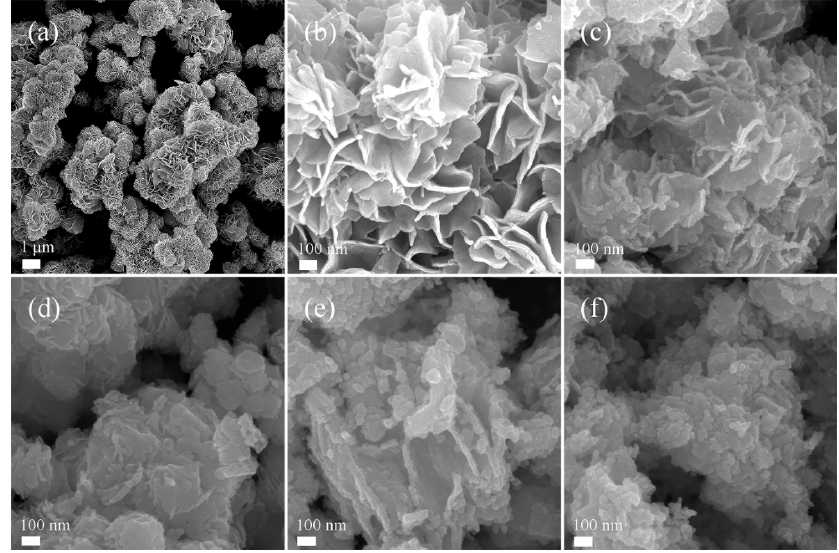
Figure 2. The morphologies of WS 2 , WS 2 / WO 3 , and WO 3 . ( a , b ) SEM images of WS 2 ; ( c – e ) SEM images of WSO ‐ 5, WSO ‐ 30, and WSO ‐ 60, respectively; ( f ) SEM image of WO 3 .